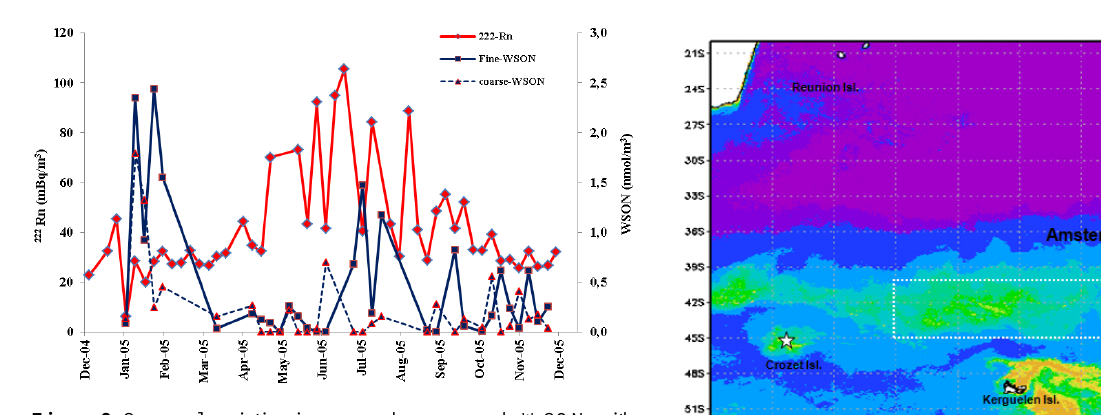
Figure 8. Seasonal variation in fine- and coarse-mode WSON with radon at Amsterdam Island. Austral summer is defined from De- cember to April and winter from May to November.